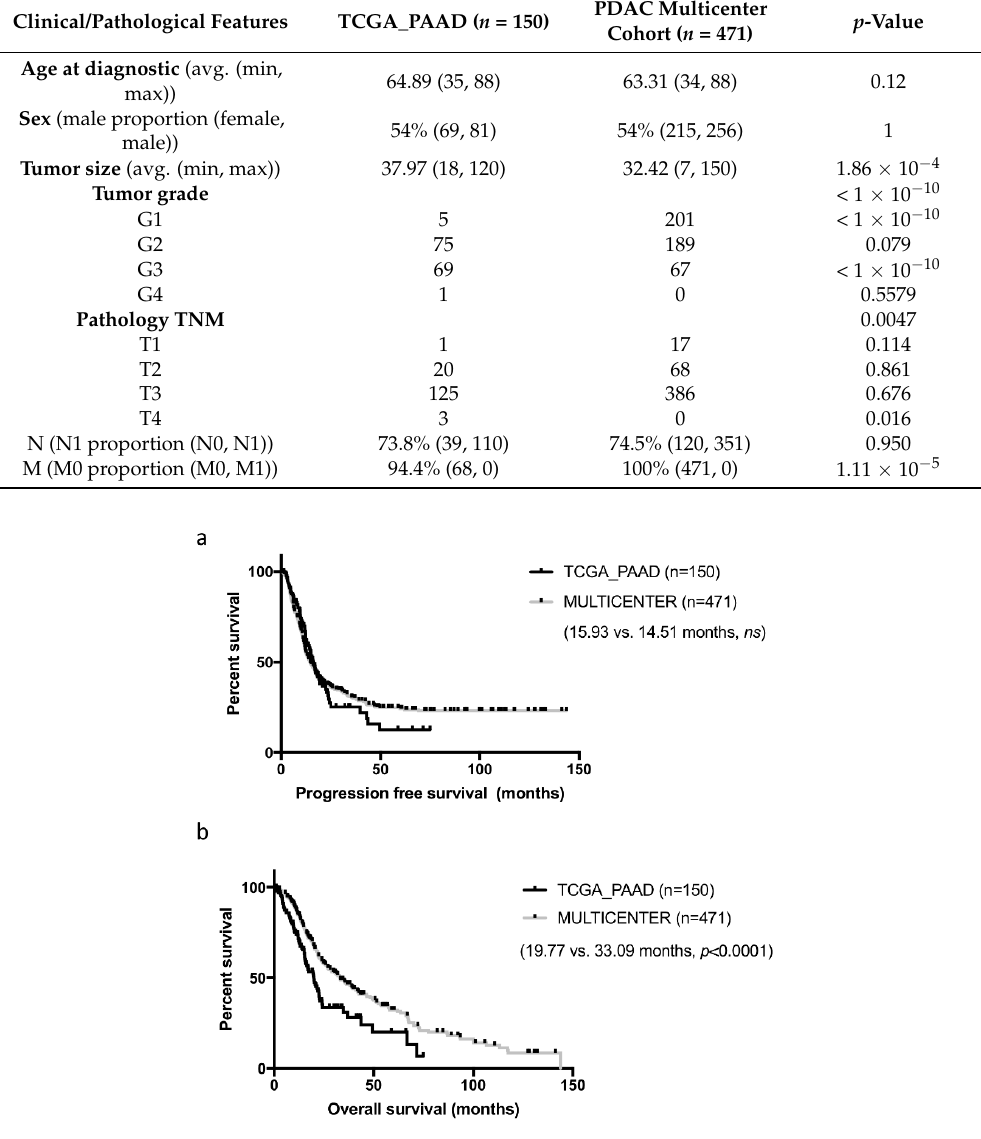
Figure 2. Progression-free and overall survival of the curated TCGA_PAAD and a PDAC multicenter cohort. Kaplan-Meier curves depicting the progression-free ( a ) and overall survival ( b ) of the curated TCGA-PAAD cohort ( n = 150) and a multicenter PDAC cohort ( n =